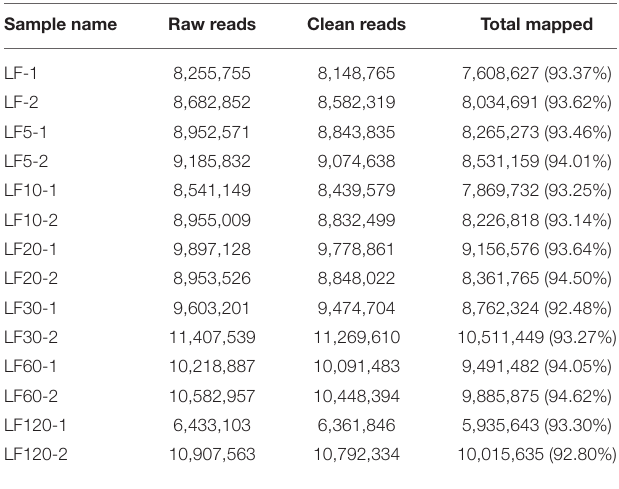
TABLE 2 | Statistics of DGE sequencing.